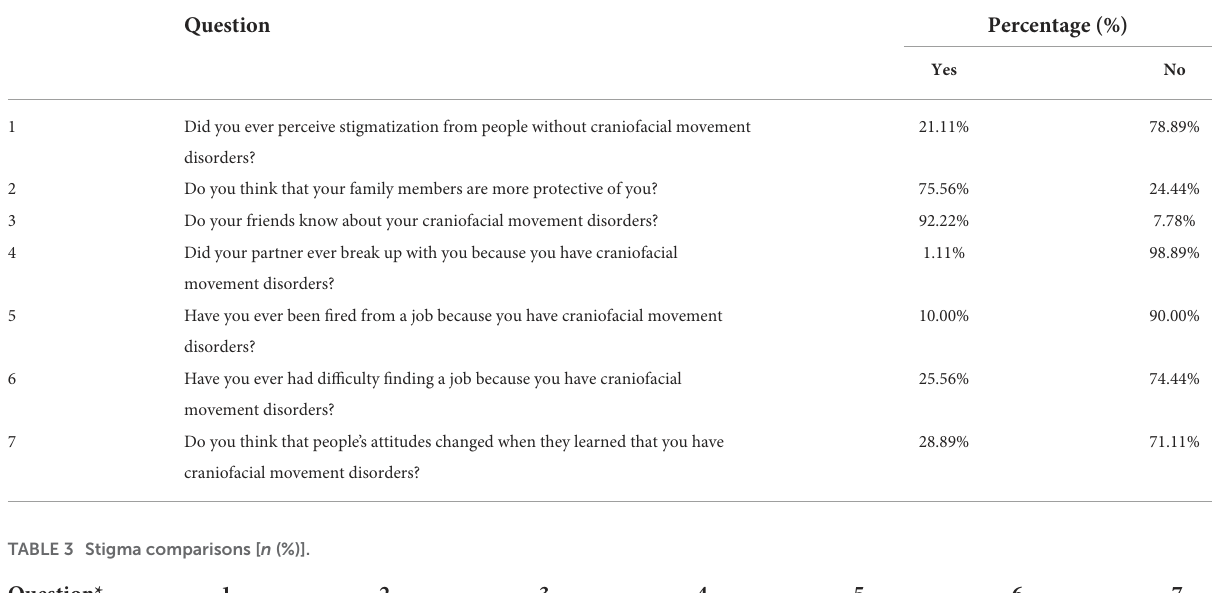
TABLE 2 Stigma-related questions ( n = 90).